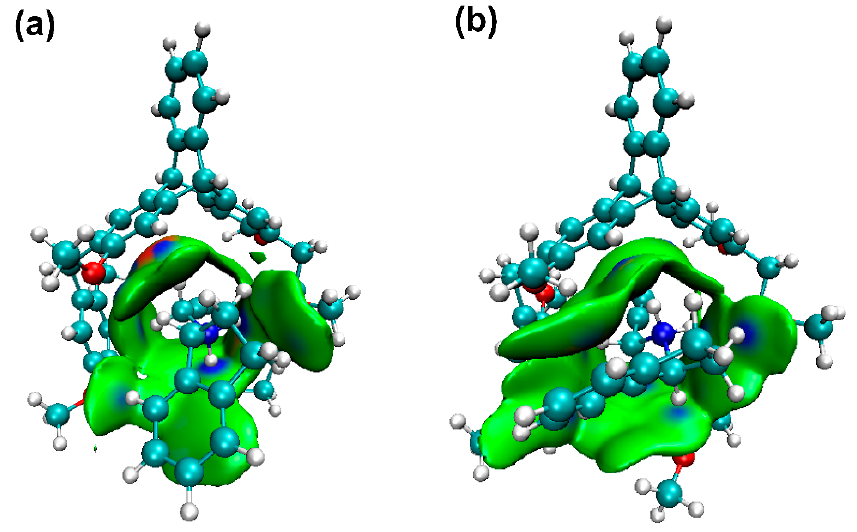
Figure 8. IGM analyses of the complexes ( a ) P - H · R - G1 , ( b ) P - H · S - G1 ( δ ginter = 0.002).